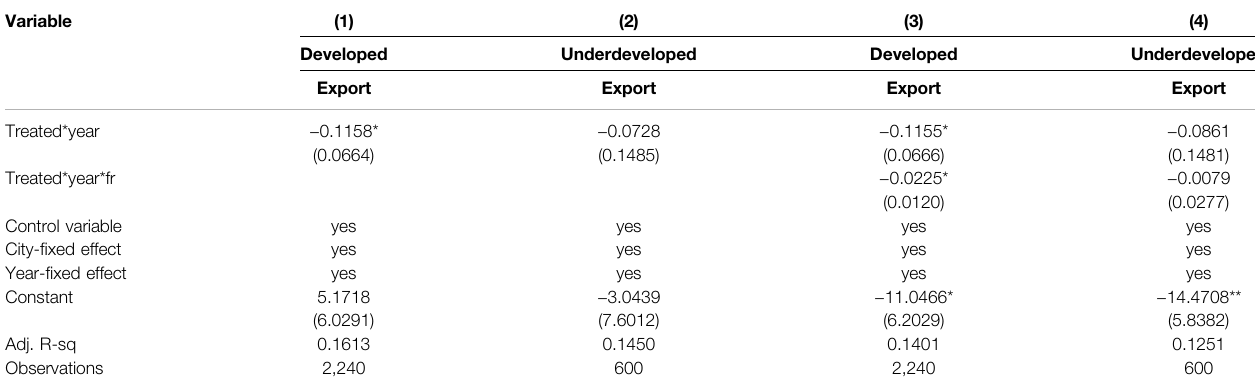
TABLE 8 | Regional heterogeneity